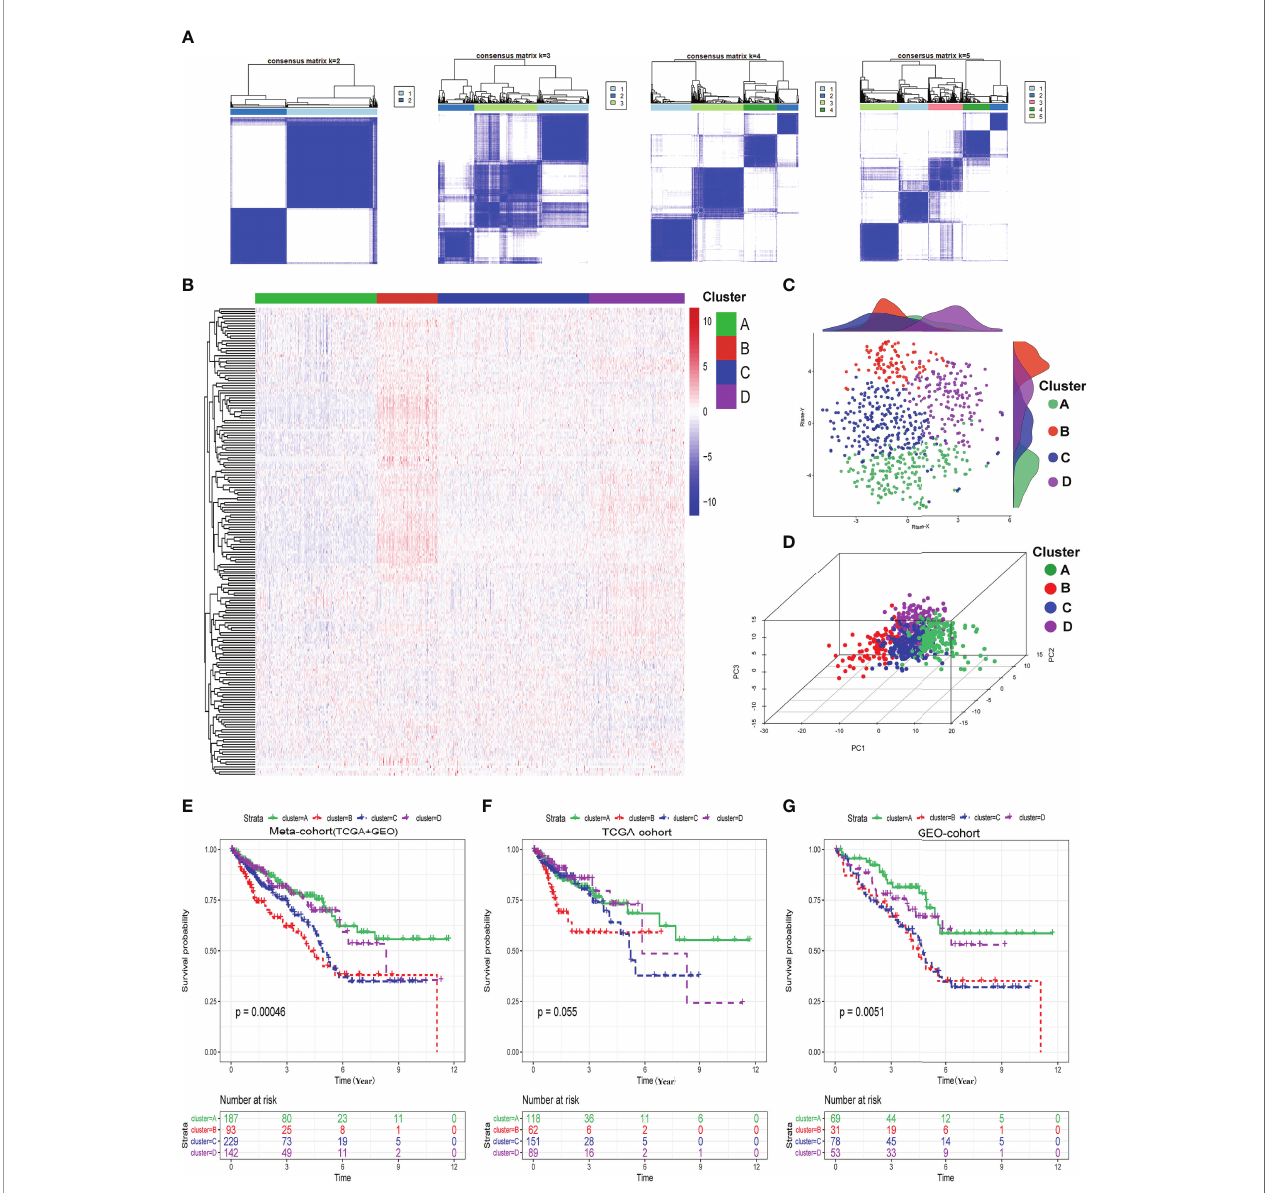
FIGURE 1 | Identi fi cation of hypoxia-related clusters. (A) Determination of four distinct hypoxia-related clusters by ConsensusClusterPlus. (B) Heatmap about the expressions of hypoxia genes among four clusters. (C) Dot plot for these four clusters by t-SNE algorithms. (D) Dot plot for these four clusters by PCA algorithms. (E – G) Survival analysis (Kaplan – Meier) in meta-cohort, TCGA cohort, and GEO